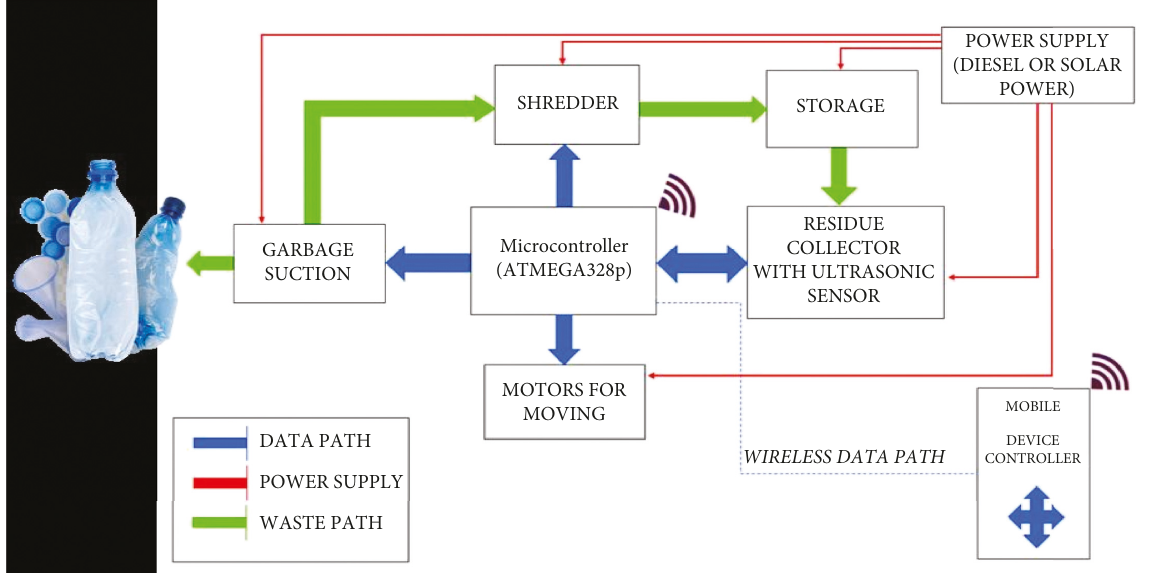
Figure 1: General process diagram of the smart garbage collector.